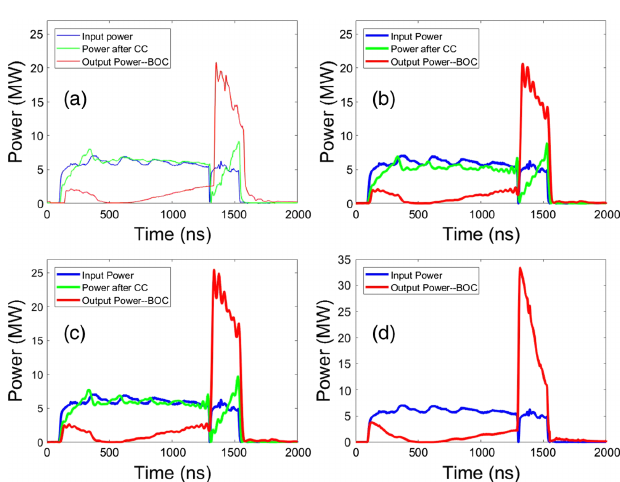
FIG. 9. (a) The measured waveforms. (b) The calculated waveforms with attenuation. (c) The calculated waveforms without attenuation. (d) The calculated waveforms of a single BOC without attenuation.